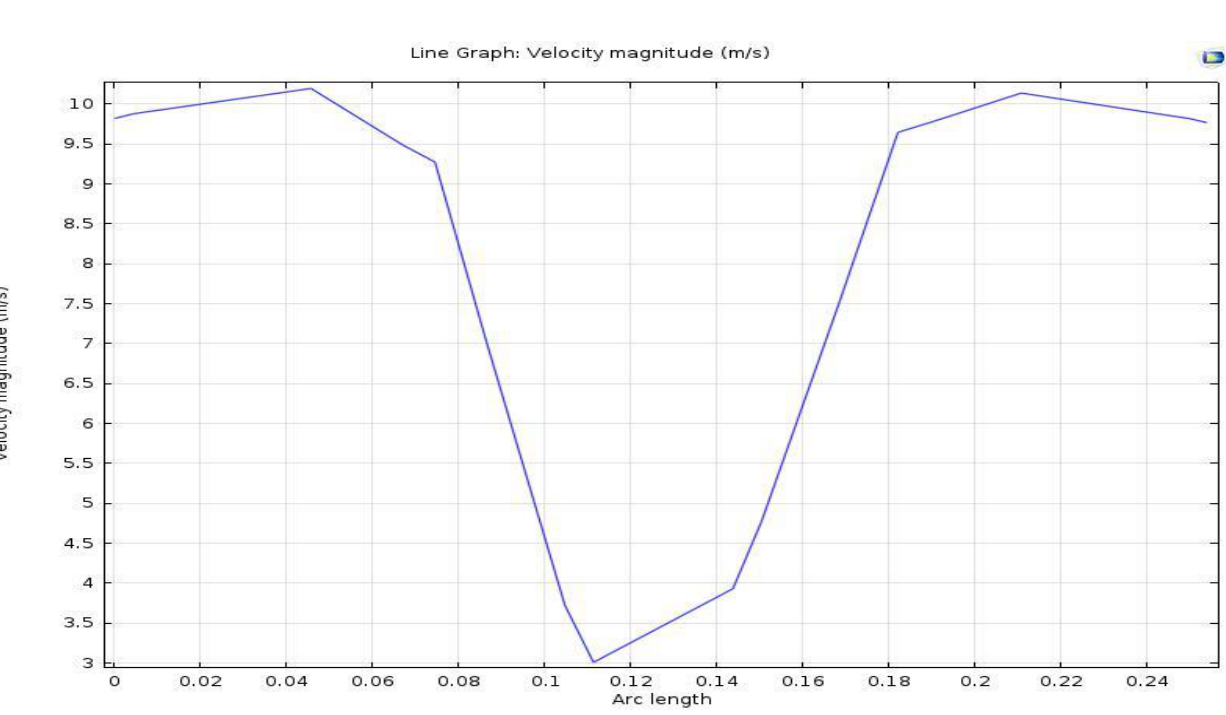
Figure 7. The airflow velocity graph at the location of turbine blades of a closed type WPP